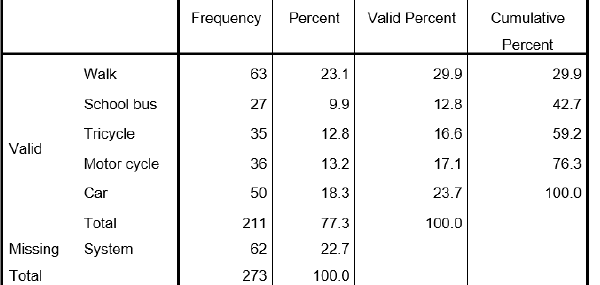
Table 1: Mode of choice to secondary schools in Lokoja